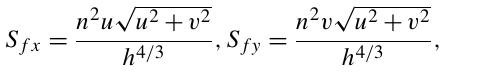
Figure 11. Velocity monitoring